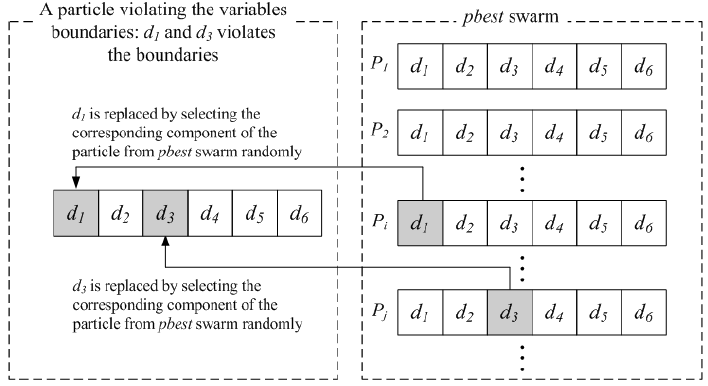
Figure 5. Illustration of the variable limits handling strategy.